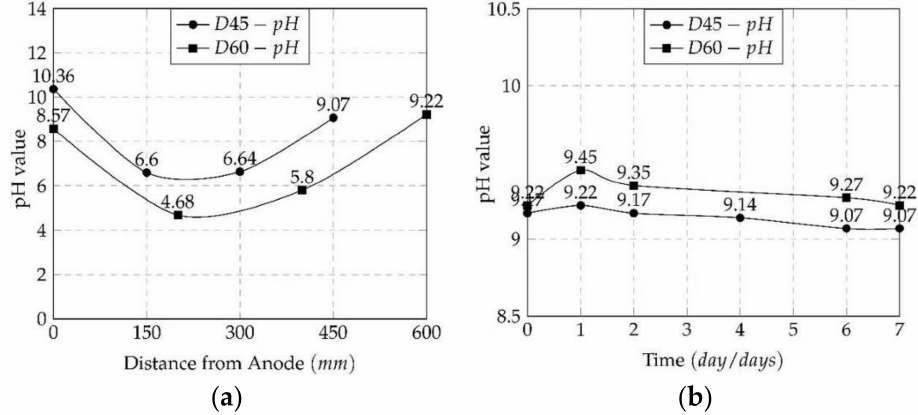
Figure 6. The pH values for D45 and D60 ( a ) along the specimen and ( b ) inside the cathode cell.